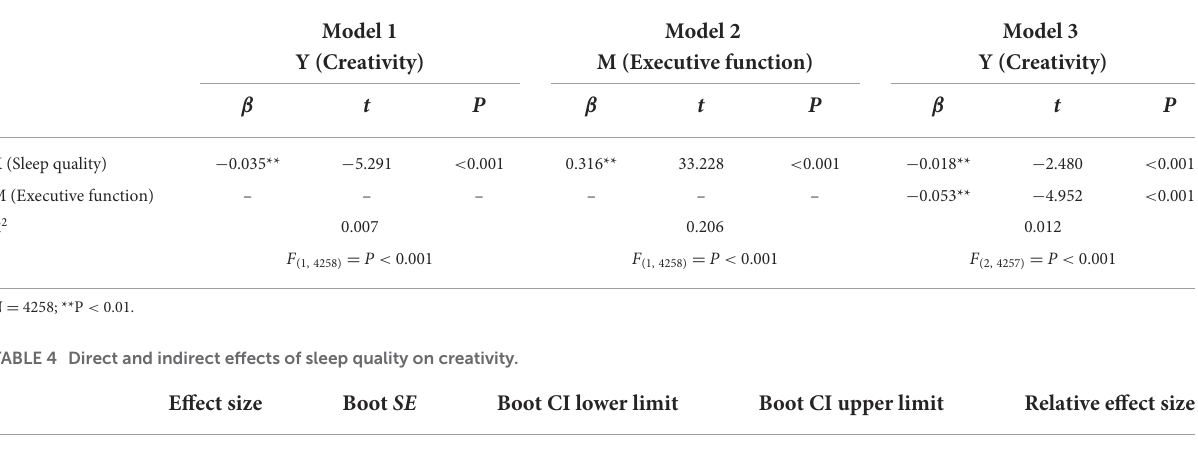
TABLE 3 Summary of hierarchical regression analyses predicting creativity.